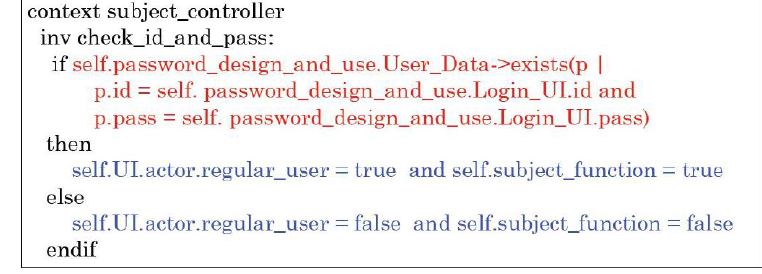
Figure 2. OCL description (Password Design and Use pattern).